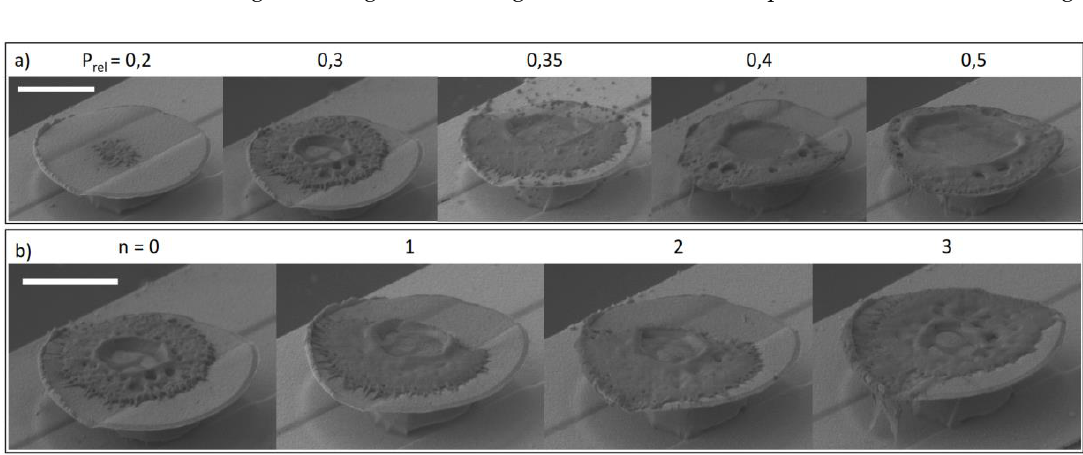
Figure 5. Power ( a ) and repetition ( b ) screening on resonators using R2. Power values are given in relative units and the repetitions are done at P rel = 0.3. The number of repetitions is given by n . Each repetition is done at the same settings as the first spot and the time between each repetition was around 5 s to allow for heat dissipation and diffusion of reactive compounds. The scale bars are 3 µm.